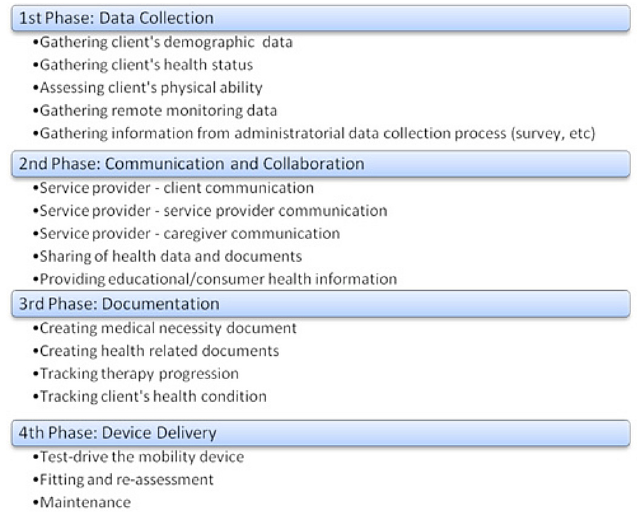
Figure 4. Phases of Remote Wheelchair Prescription Service